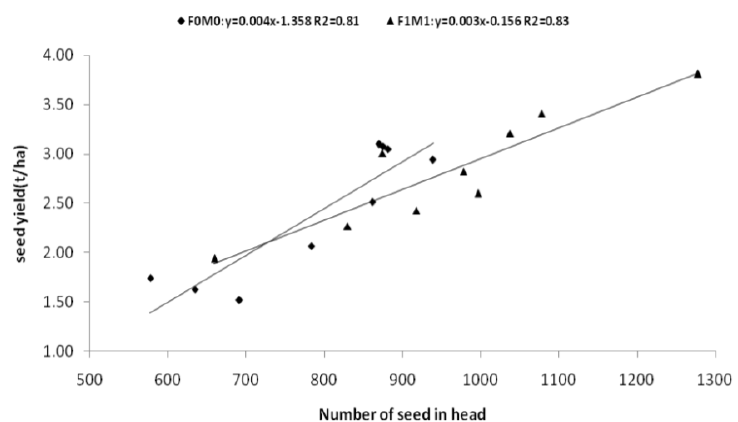
Fig. 4. Relationship between seed yield and number of seed per head in case of Mn and Fe(F M ) together, and lack of Mn and Fe(F M 1 1 0 0 defoliation had little effect on seed yield, which seems rea- sonable because of the large sink due to a positive effect of the sink size on power source. The remaining leaves